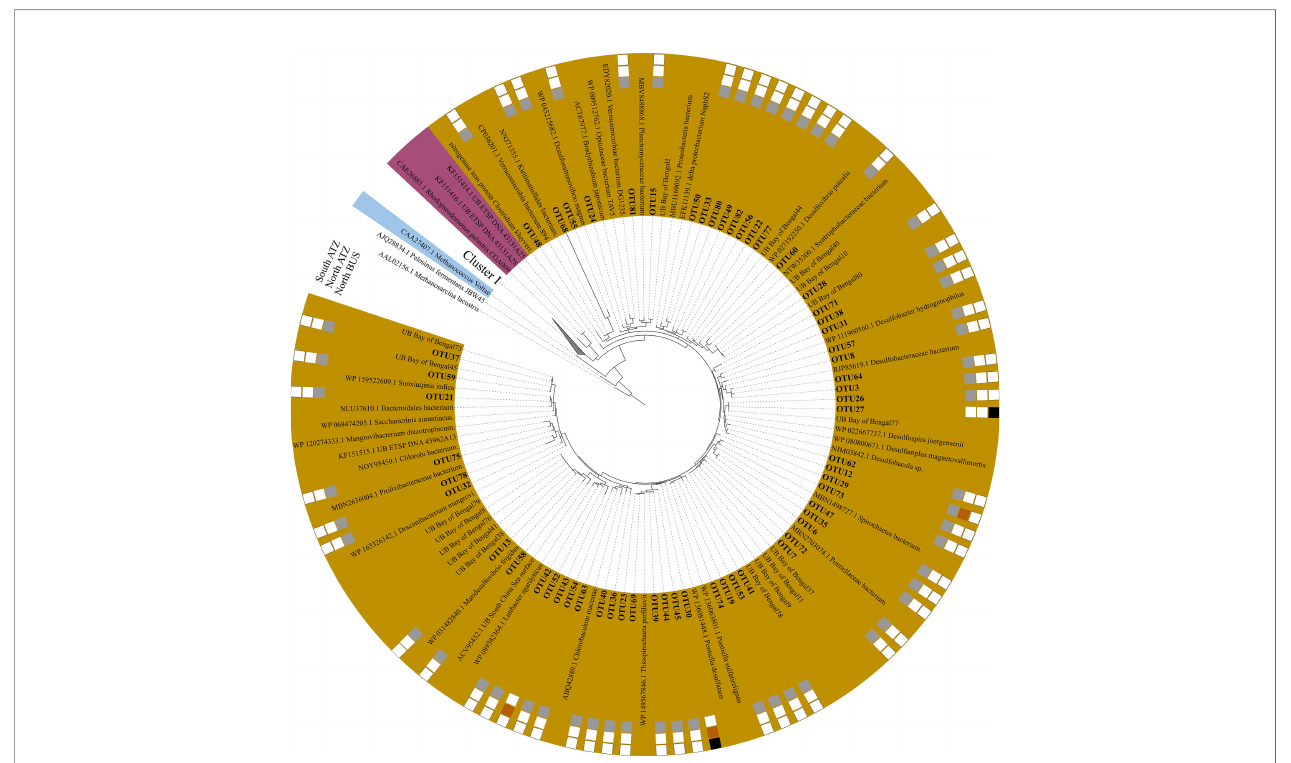
FIGURE 5 | Maximum likelihood tree of Cluster II, III, and IV nifH -amino acid sequences. The phylogenetic tree is based on a Poisson model with 1000 bootstraps. OTUs are shown in bold nearest to their next cultivated relatives. Cluster II is shown in purple, Cluster III in brown and Cluster IV in